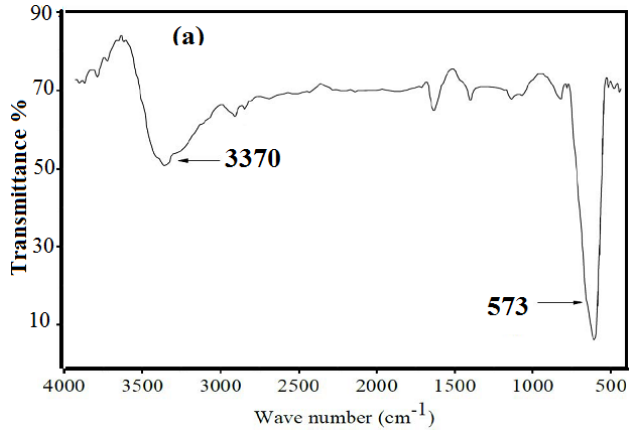
O NPs; and ( b ) Fe 3 4